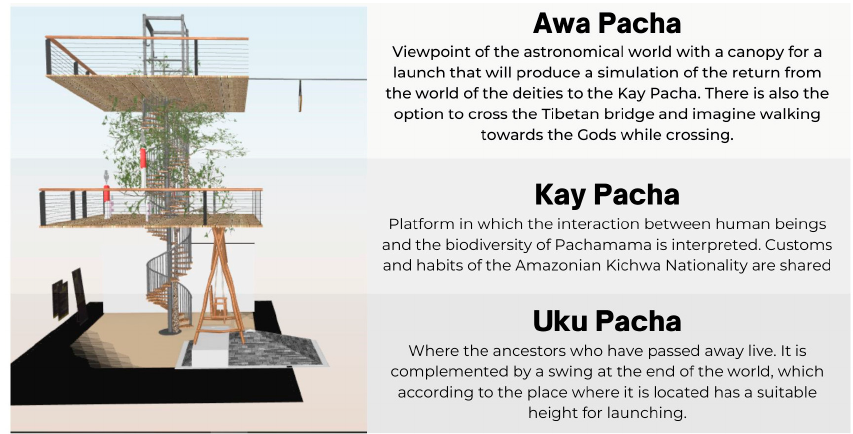
Figure 3. Mirador del Ceibo “The three worlds”.